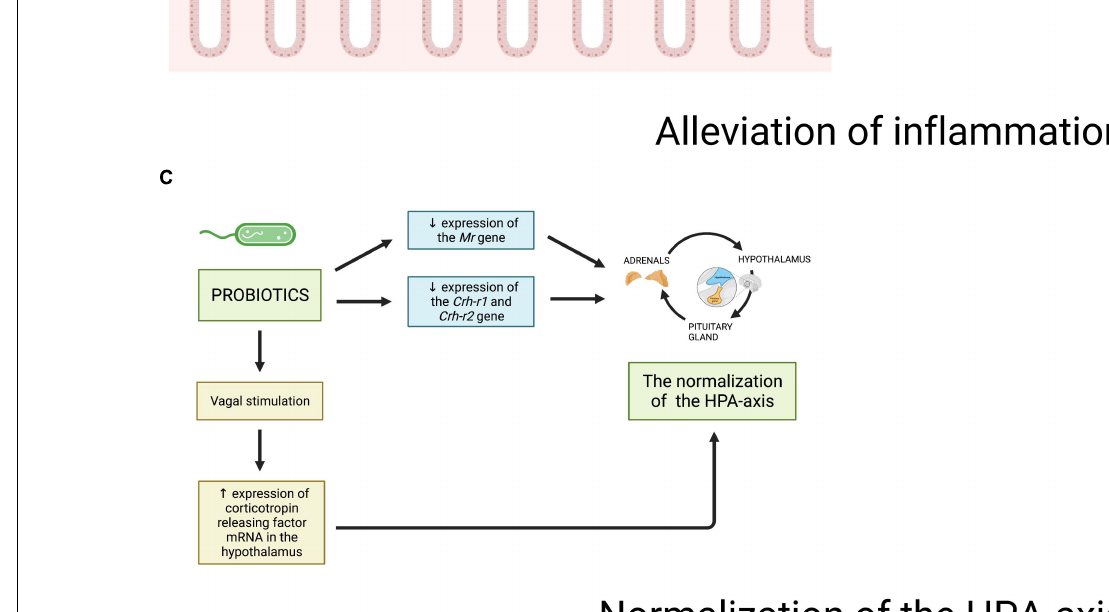
FIGURE 3 | Schematic representation of probiotic bacteria actions. Source: authors; created in BioRender.com. Probiotic bacteria may reduce the oxidative stress, decrease the inflammation and improve the functioning of the HPA-axis through a wide variety of actions.